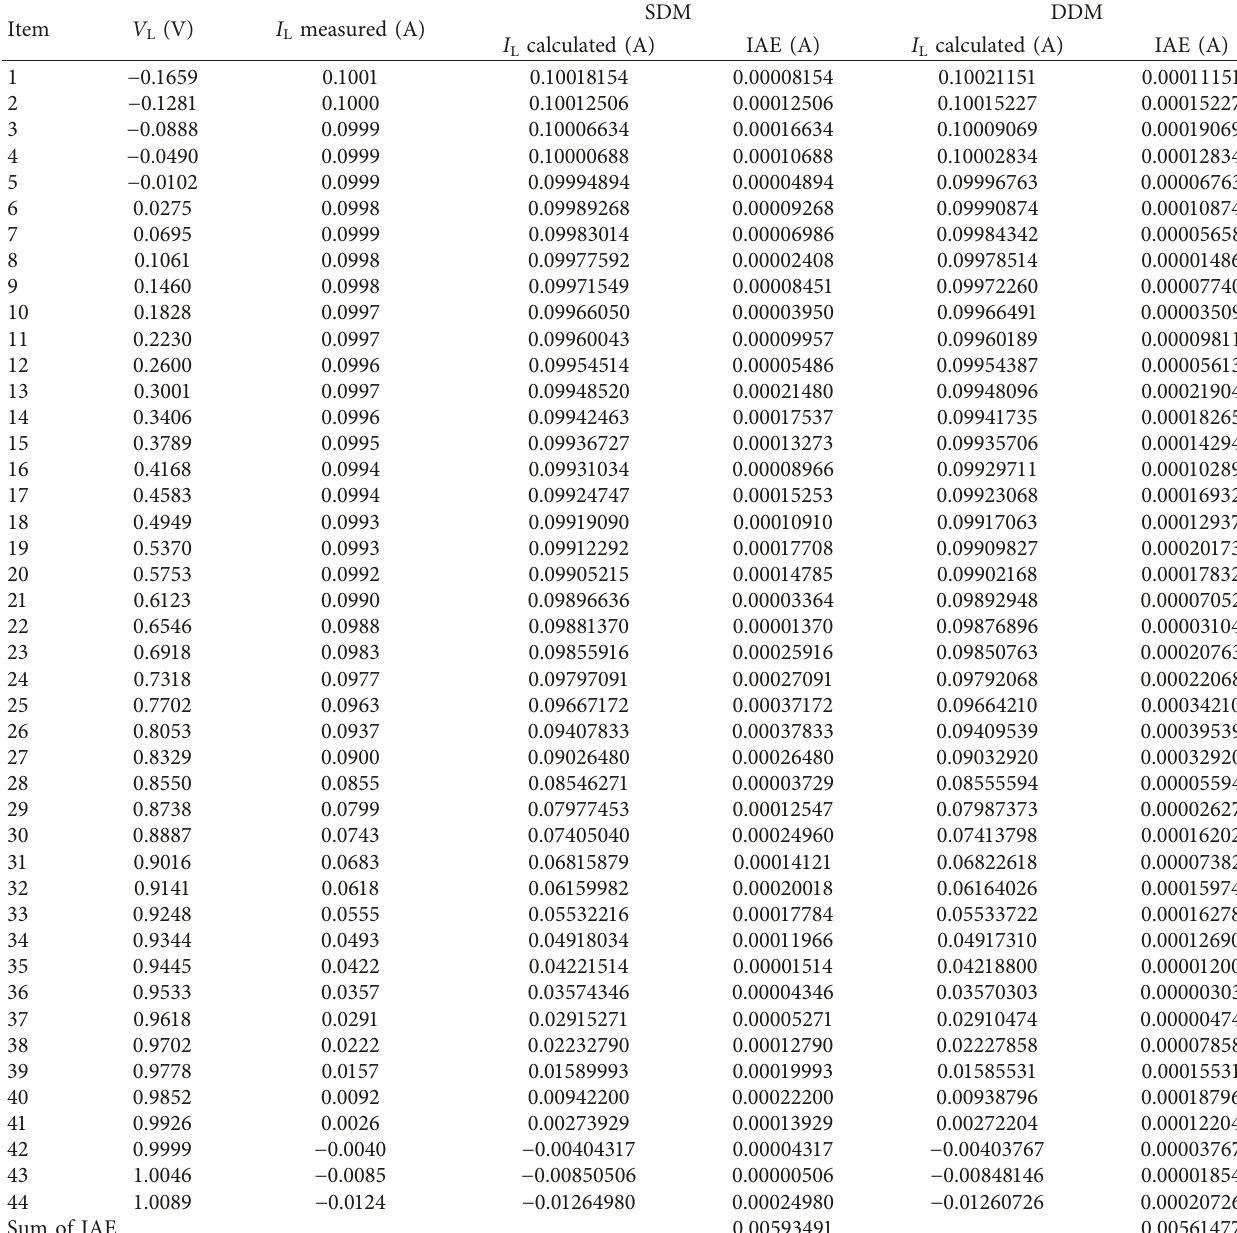
Table 8: Calculated results for the PVM 752 GaAs thin film cell by